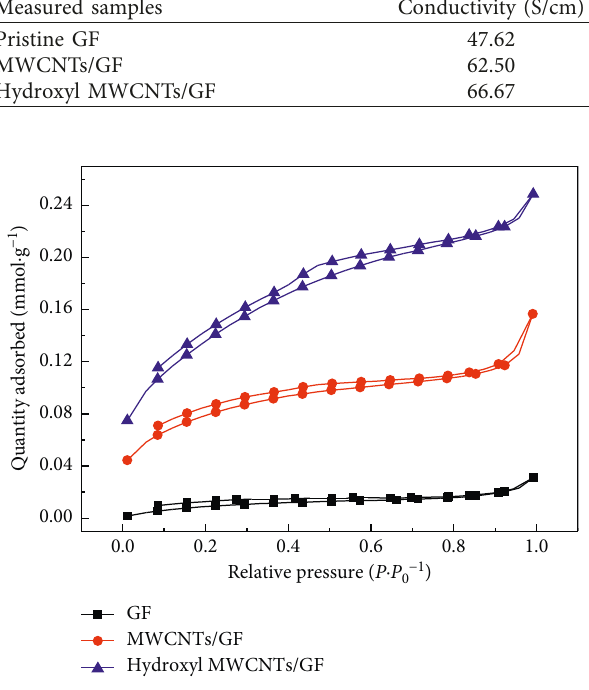
Figure 2: Nitrogen adsorption-desorption